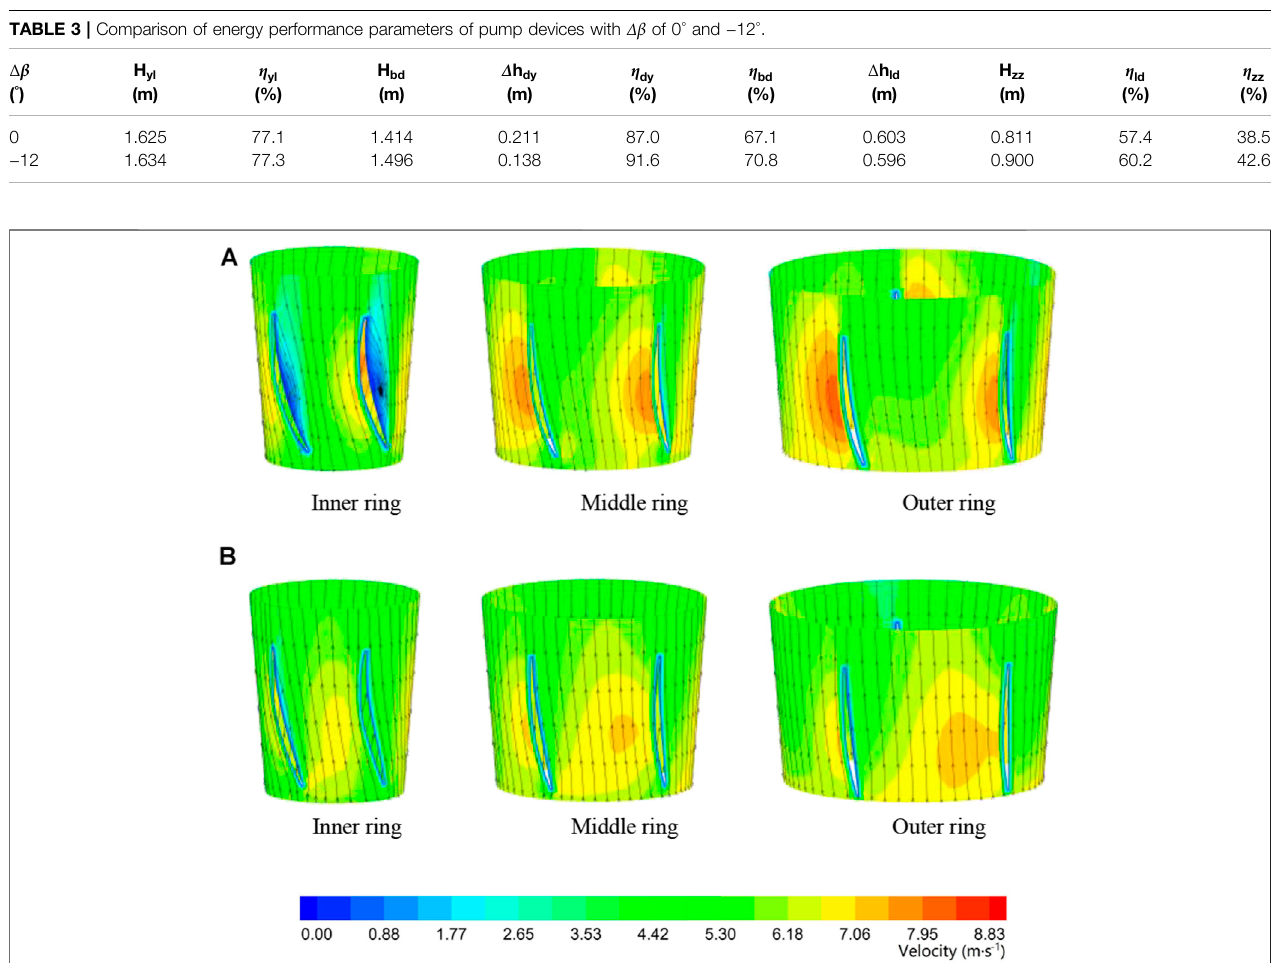
FIGURE 14 | Guide vane fl ow fi elds with Δβ of 0 ° and − 12 ° , respectively. (A) Δ β = 0 ° , (B) Δ β = − 12 ° .